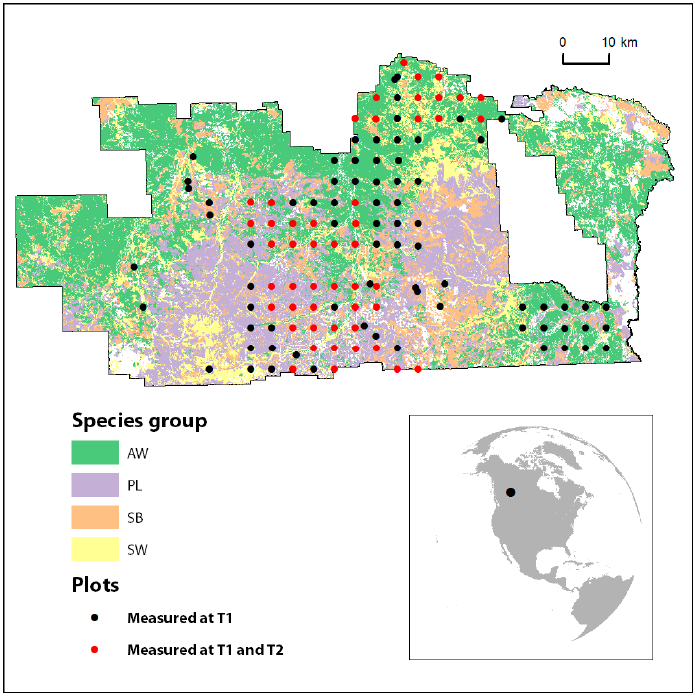
Figure 1. Location and outline of the study area.